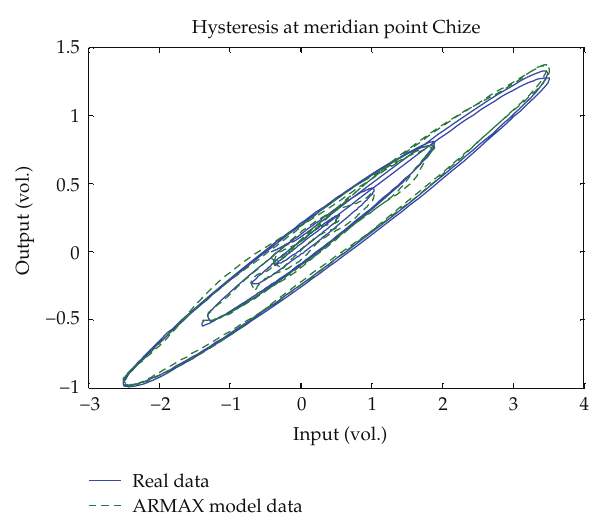
Figure 6: Model validation of the ARMAX model for hysteresis in meridian.